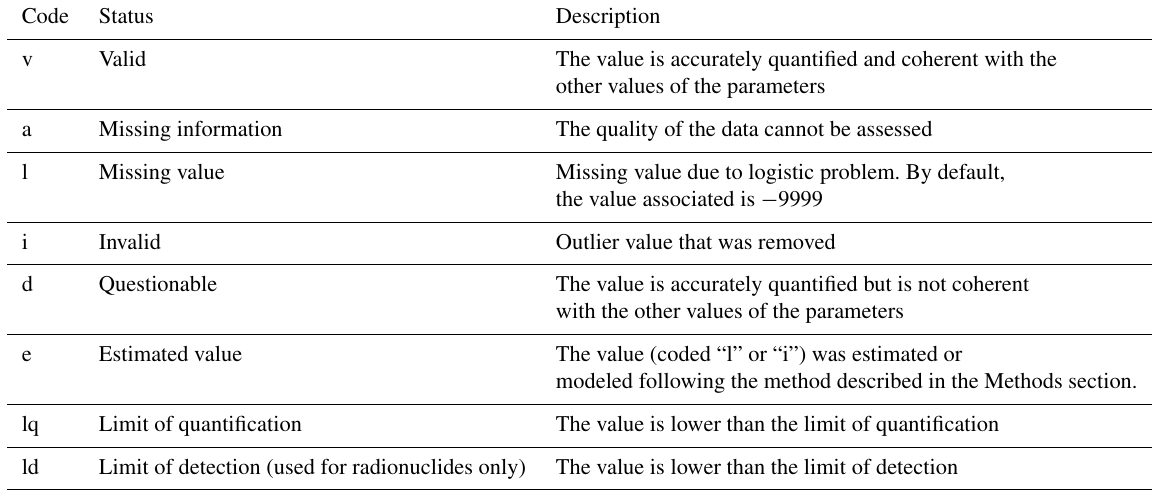
Table 1. Quality codes used in the BDOH